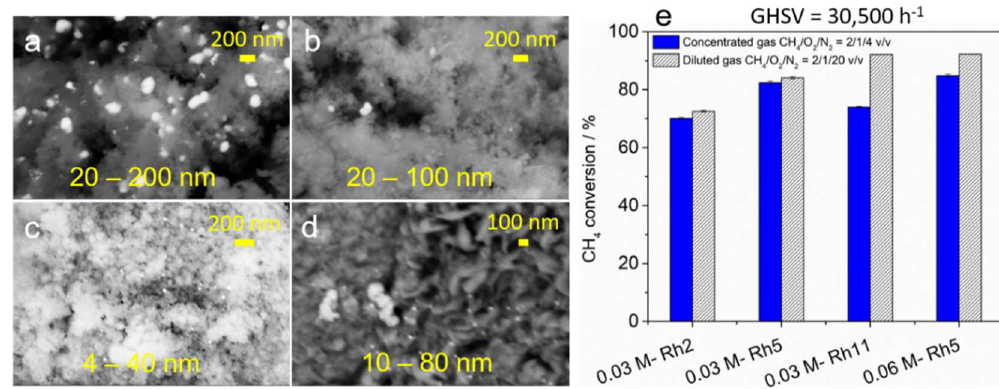
Figure 7. Field emission gun scanning electron microscopy (FEG-SEM) images of Rh spent catalysts: ( a ) 0.03 M, Rh/Mg/Al = 11/70/19 (a.r.%), ( b ) 0.03 M, Rh/Mg/Al = 5/70/25, ( c ) 0.03 M, Rh/Mg/Al = 2/70/28, ( d ) 0.06 M, Rh/Mg/Al = 5/70/25, and ( e ) CH 4 conversion of the catalysts in the catalytic partial oxidation at T oven = 750 °C, 35,000 h −1 and feeding diluted and concentrated feedstocks. The syntheses were performed at −1.2 V vs. SCE for 2000 s and pH 3.8. The catalysts were calcined at 900 °C for 12 h. Adapted from